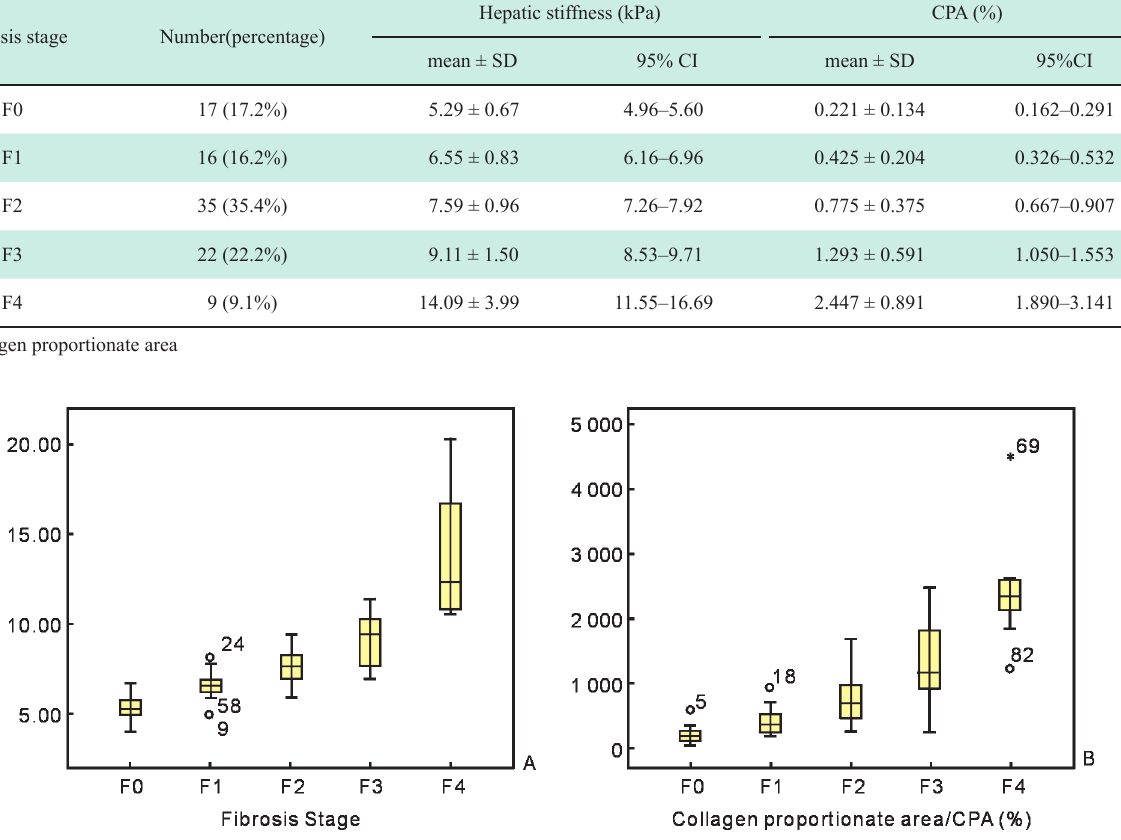
Figure 3 Boxplot (A) showing the distribution of hepatic stiffness measured by shear wave elastography (SWE) according to histological fibrosis stages. The top and the bottom of each box represent the 25th and the 75th percentiles, and the length of the box indicates the interquartile range. The line within the box is the median value. ○, discrete value. Boxplot (B) of the distribution of collagen proportionate areas (CPAs). ○, discrete value; *, extreme